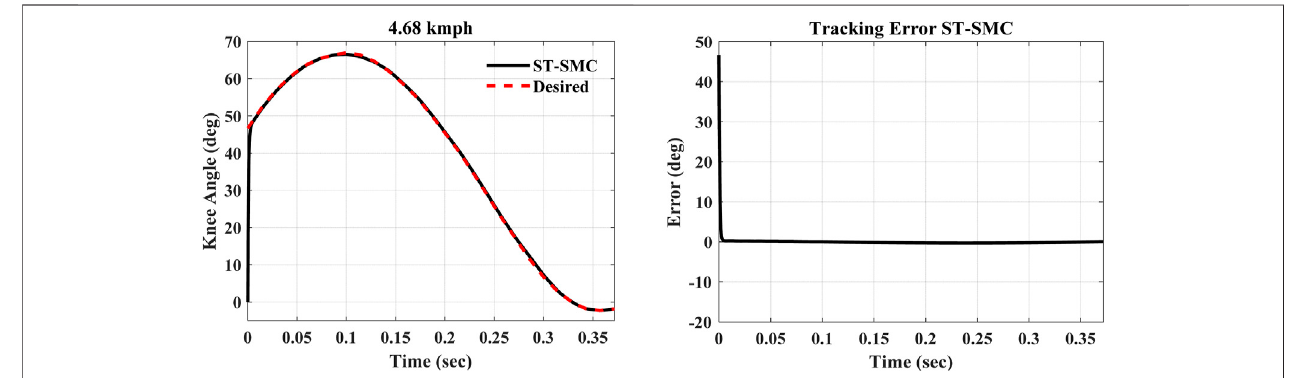
FIGURE 5 | Tracking performance and error of the